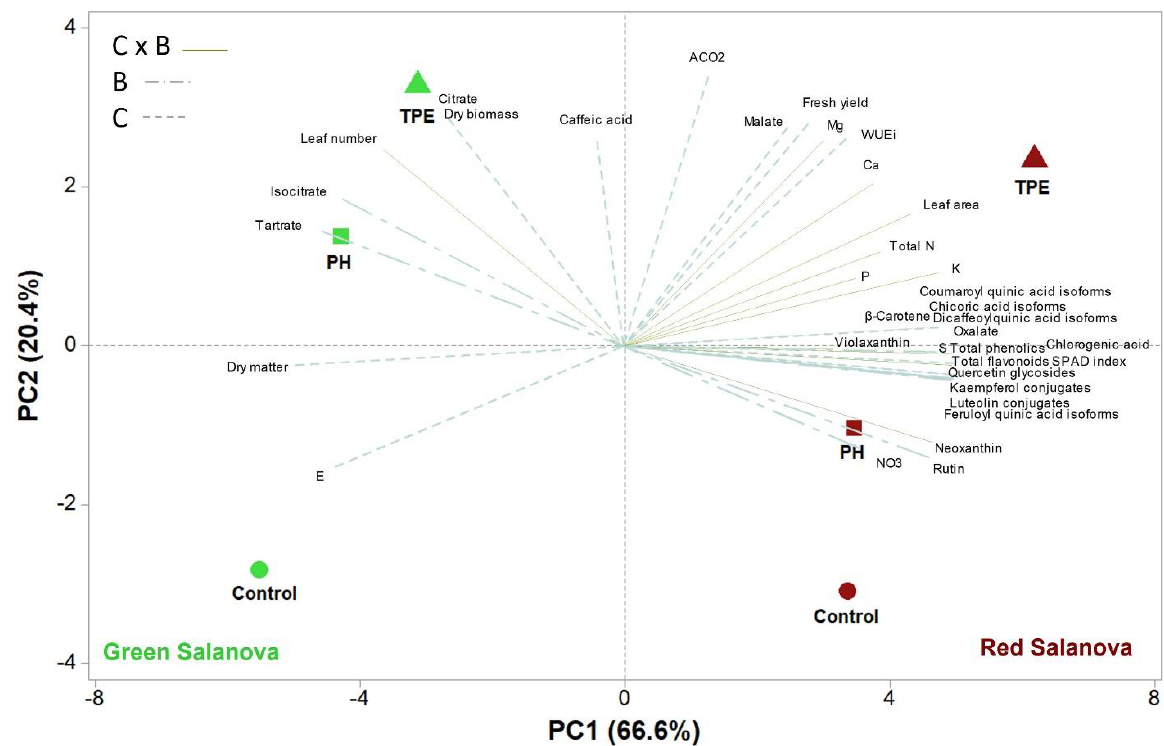
Figure 2. Principal component loading plot and scores of principal component analysis (PCA) of morphological parameters, mineral nutrients, gas exchange data, SPAD index, organic acids, carotenoids, phenolic acids, and flavonoids of the two lettuce cultivars (green and red salanova) treated with PH and TPE biostimulants. Scaled loading vectors are drawn as a yellow-green continuous line for variables that were significantly affected by both the cultivar and the biostimulant treatments (C x B), blue-green dashed large lines and dots for those significantly affected by the biostimulants (B), and blue-green dashed small lines for those significantly affected by the cultivar (only one occurrence). PH : Trainer ® , TPE : Auxym ® .